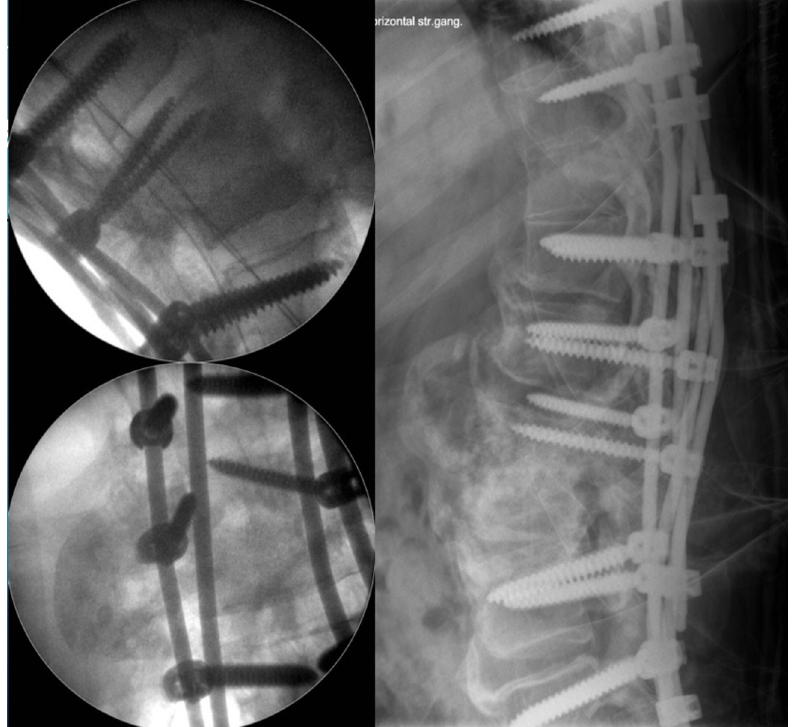
Figure 4. Intra-operative fl uoroscopy image showing fi nal fi xation with four rod construct and immediate post operative radiograph showing good 3D correction of the deformity with stable fi